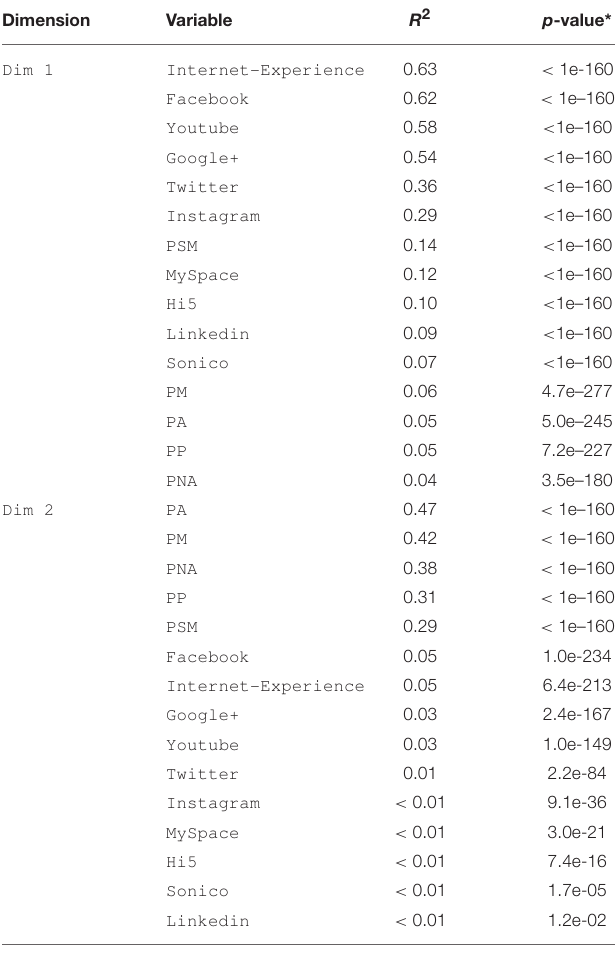
TABLE 3 | Significance and correlation of variables by principal dimension.